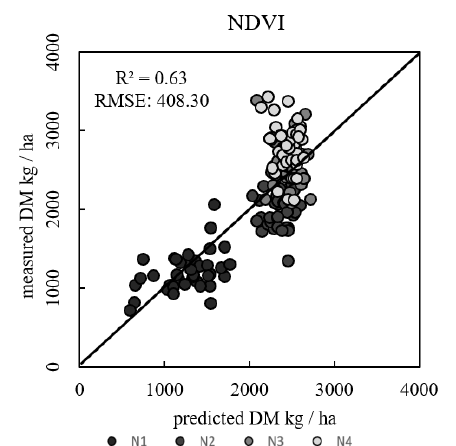
Figure 8. Measured versus predicted dry biomass yield [kg / ha] for NDVI.